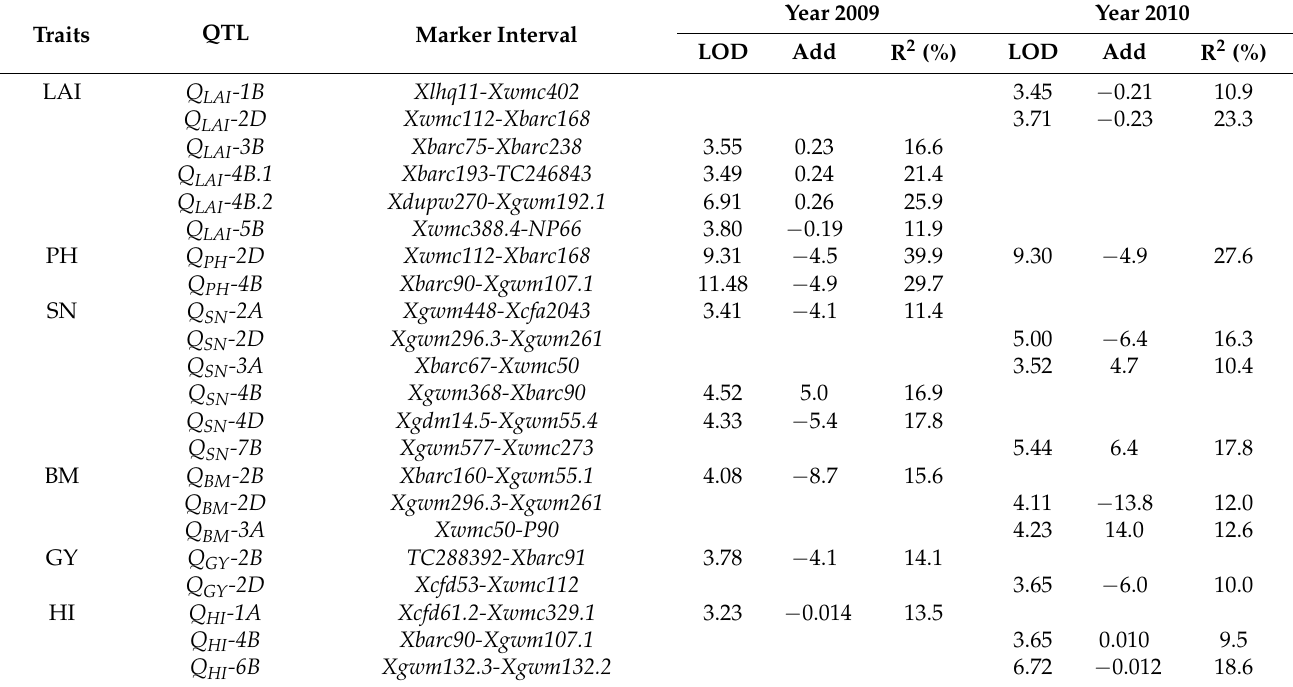
Table 3. Summary of QTL for the LAI and grain yield-related traits detected with composite interval mapping by using the “Xiaoyan 54 × Jing 411” recombinant inbred line